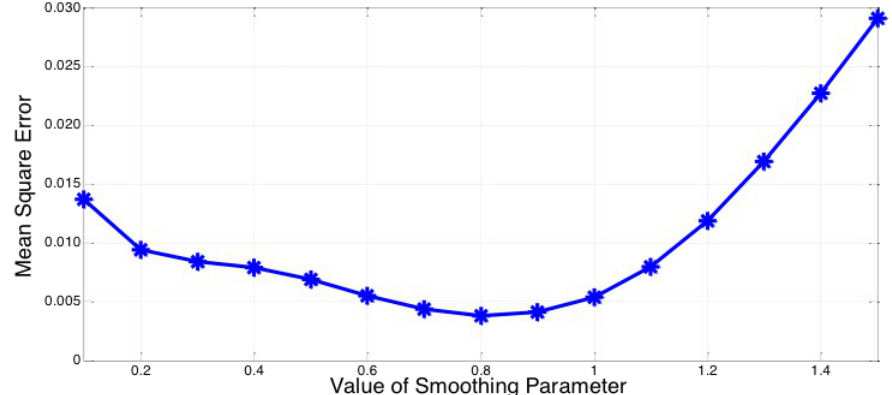
Figure 2. Influence of smoothing parameter on GRNN model (data from Section